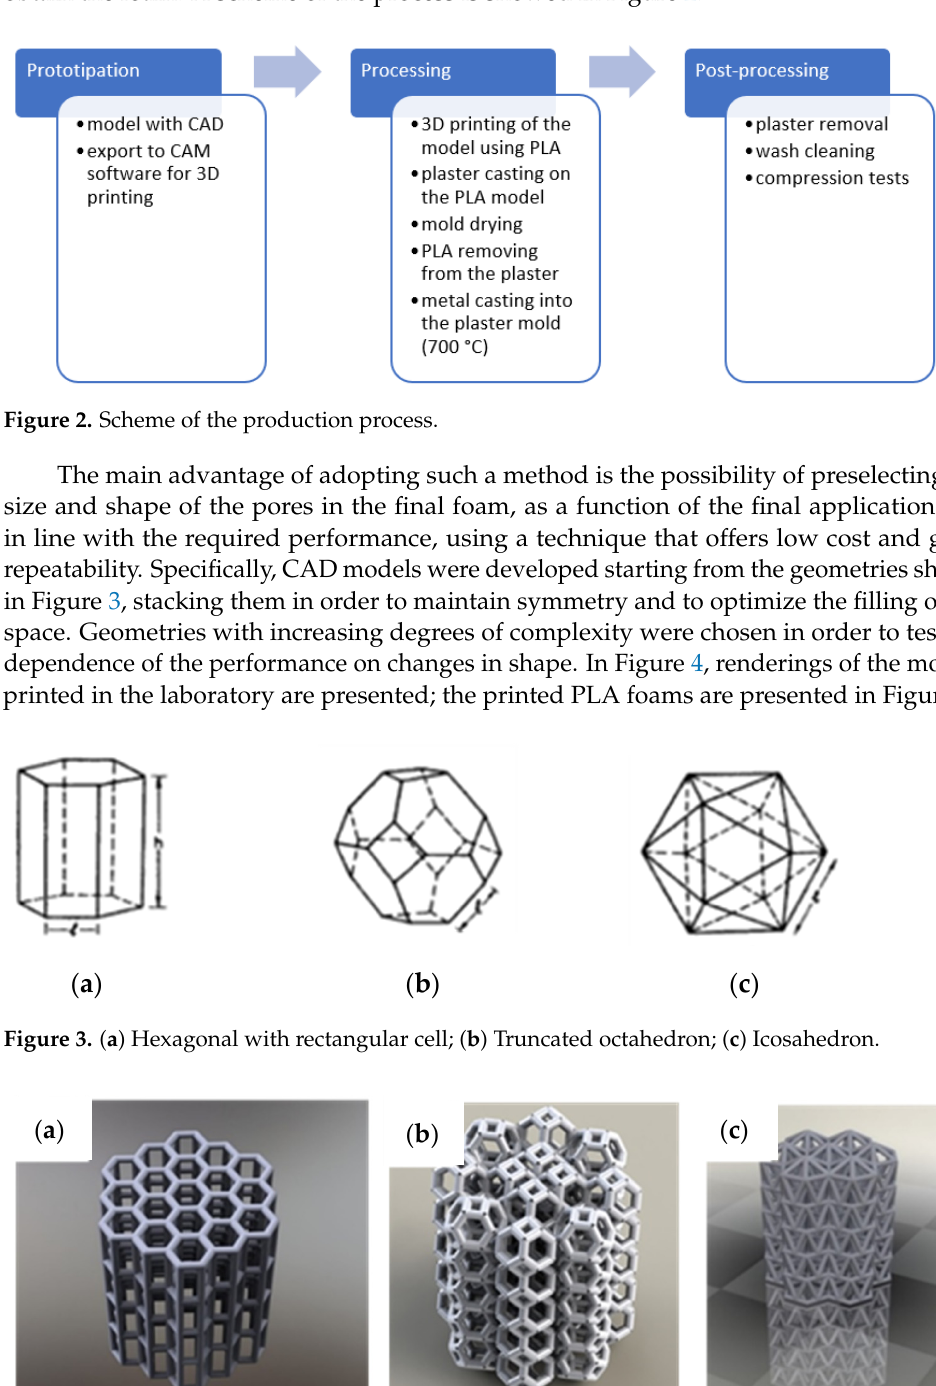
Figure 4. Renderings of CAD models: ( a ) hexagonal with rectangular cell; ( b ) truncated octahedron; ( c ) icosahedron.